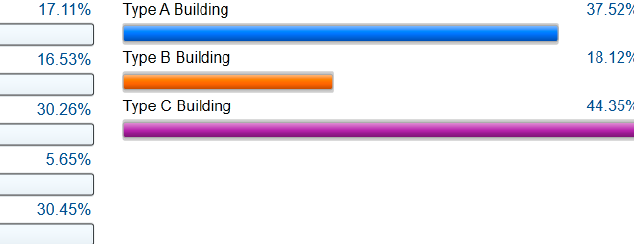
Figure 3. The original evaluations by experts (%) that provide a relevance ranking of sub-criteria of the group of criteria “building” with regard to the choice of adequate office space for BPO tenants.